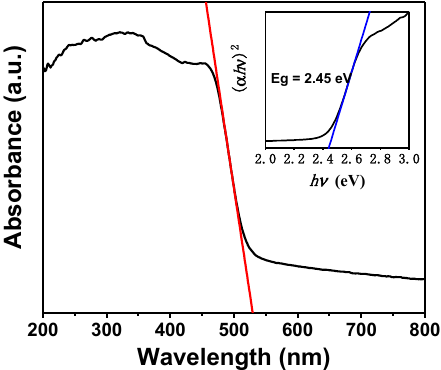
Figure 3. UV-Vis diffuse reflectance spectra and band gap of Ag 3 PO 4 .